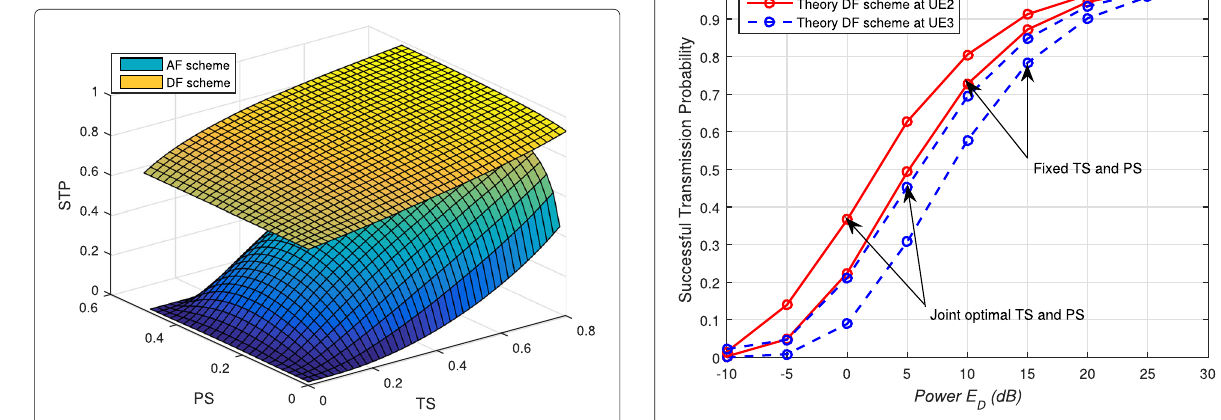
Fig. 12 STP versus TS and PS at UE2